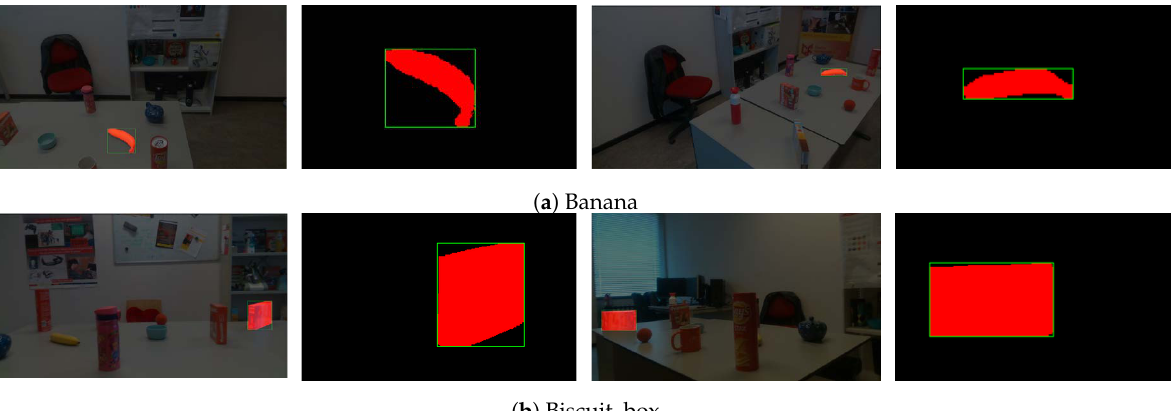
Figure 13. Examples of segmentation masks and bounding boxes for different